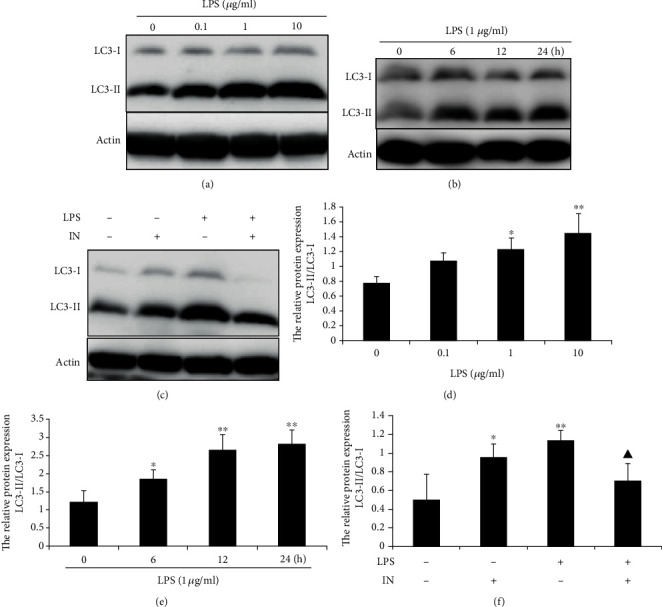
LPS-induced autophagy was mediated by TNF-α in THP-1 cells. (a) LPS-induced autophagy in a dose-dependent manner. THP-1 cells were treated with indicated concentration of LPS for 12 h. (b) THP-1 cells were treated with 1 μg/ml LPS for 6, 12, or 24 h. (c) Effect of specific anti-TNF-α monoclonal antibody infliximab on LPS-induced autophagy. THP-1 cells were preincubated with 5 μm infliximab for 1 h followed with 1 μg/ml LPS for 12 h. (d, e, and f) Densitometric analysis of the blots showing the ratios of LC3-II to LC3-I. Data were represented as the means ± S.D. (N = 4, ∗p < 0.05, ∗∗p < 0.01 vs. control; ▲p < 0.05 vs. LPS). IN: infliximab.